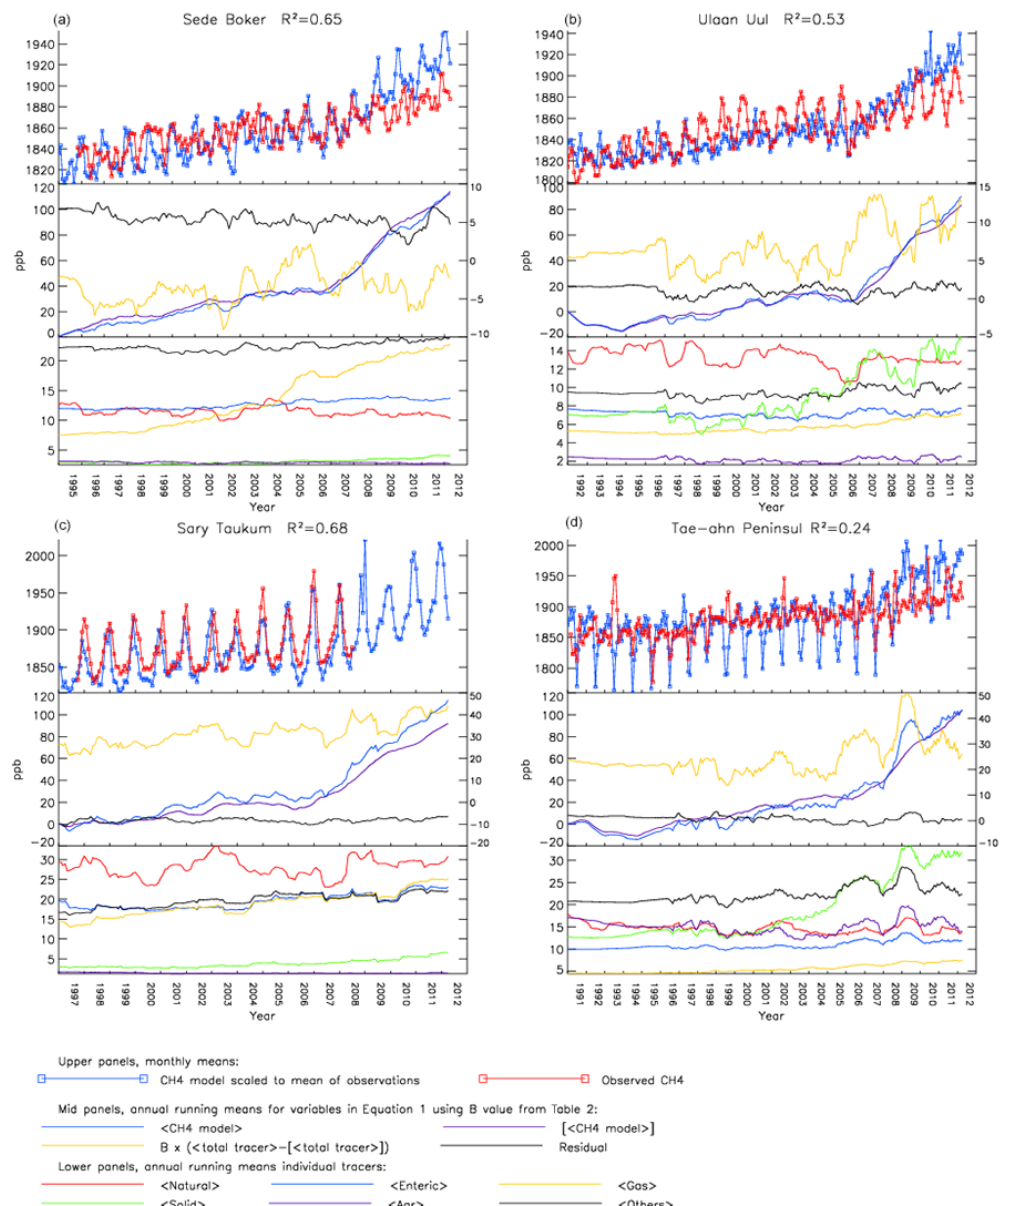
Figure 9. Evolution of CH 4 and tracers at stations ( a : Sede Boker, b : Ulaan Uul, c : Sary Taukum, d : Tae-ahn Peninsula) near Asian emission sources. See Fig. 6 caption for further